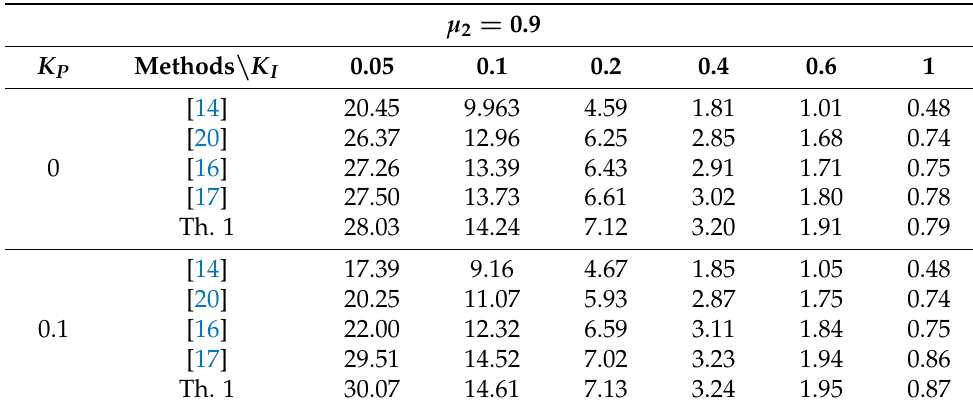
Table 5. MAUBs h 2 for h 1 ( t ) = 0 and µ 2 = 0.9 under one-area LFC